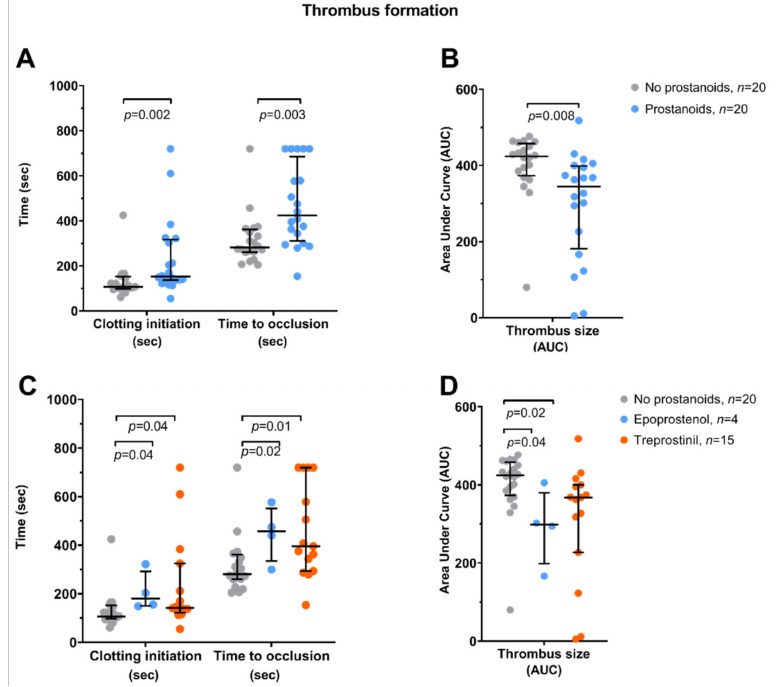
Figure 4. Platelet-rich thrombus formation measured in a whole blood perfusion system using the microchip containing capillaries coated with type 1 collagen under arterial shear rate (2000 s − 1 ). ( A , B ) Patients receiving prostacyclin analogues and not treated with prostacyclin analogues. Values were compared using the Mann–Whitney U test and shown as the median and interquartile range. ( C , D ) Comparison between no prostacyclin analogues, epoprostenol, and treprostinil. Values were compared using the Kruskal– Wallis test with Dunn’s correction for multiple comparisons and shown as the median and interquartile range. T10—onset of thrombus formation. Occlusion time—complete occlusion of the capillary. Area under curve (AUC)—parameter reflecting platelet-rich thrombus size.